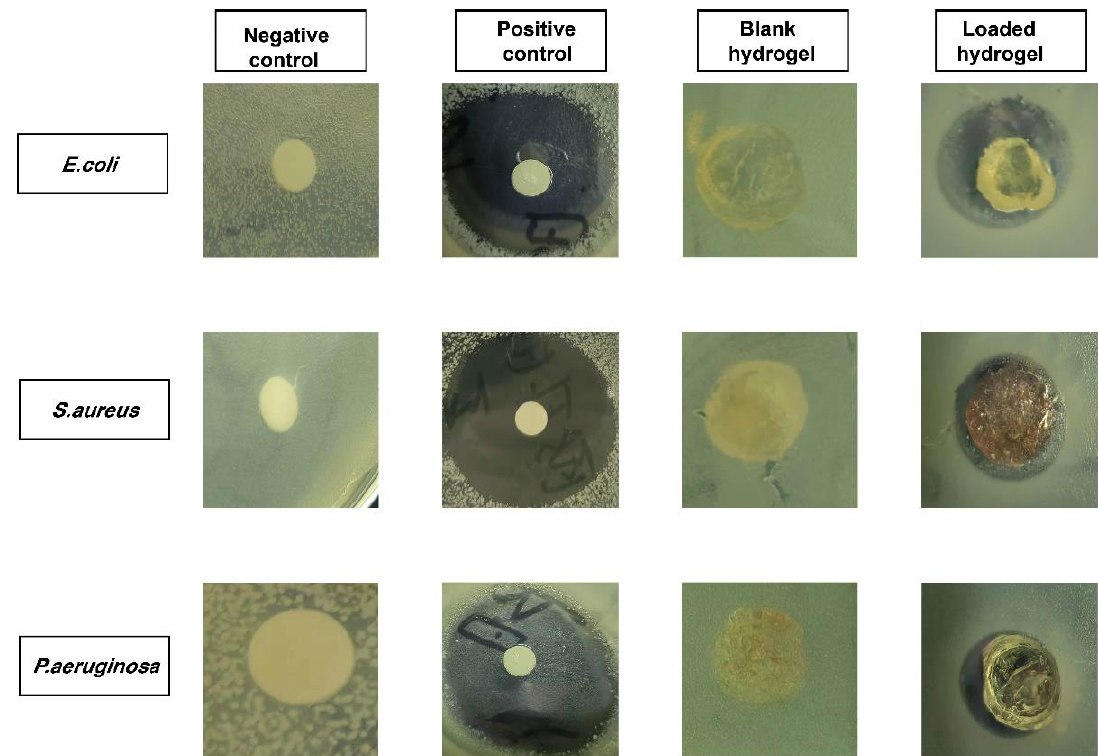
Figure 11. Antibacterial effects (zone of inhibition) of SA-g-AMPS hydrogels.